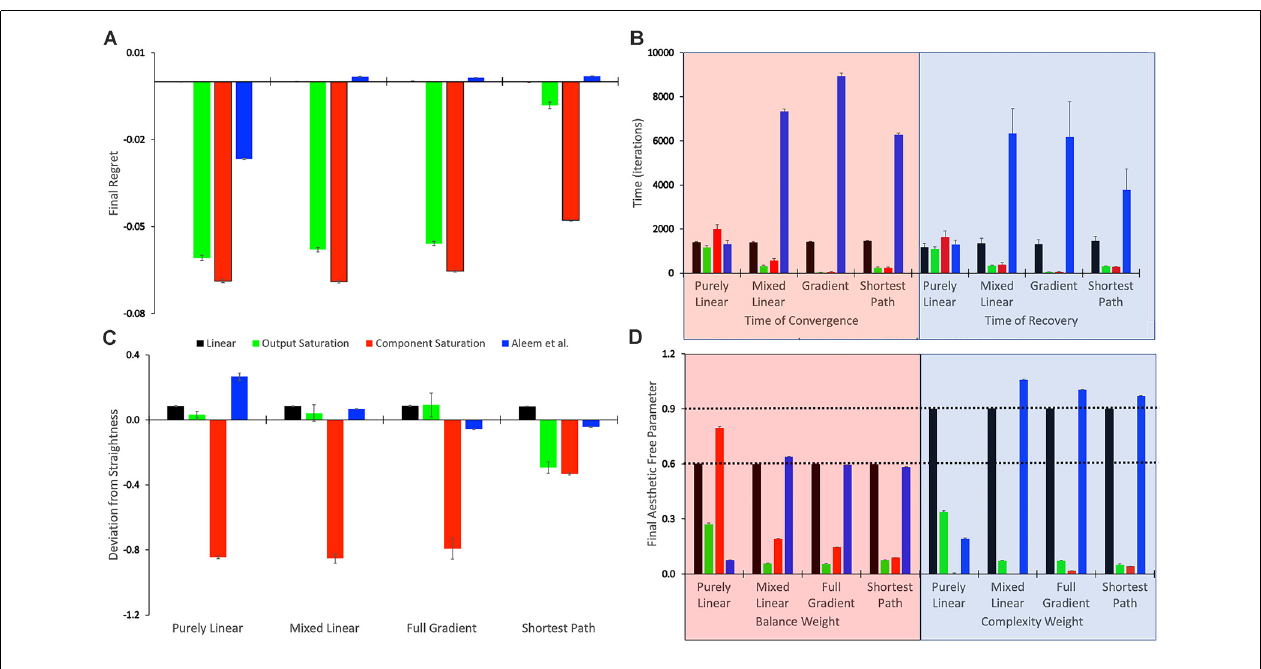
FIGURE 3 | Statistics of the tested conditions ( Table 1 ). (A) Final regret. (B) Times of convergence and of recovery from fluctuation errors. (C) Deviation from straightness. (D) Final free parameters of the value functions. each of these statistics was measured 10 times for each of the reward models, with the means and standard errors displayed. Color bins indicate the different reward models (colors matched to Figures 2E,F ). We group the 16 conditions in sets of four according to the experimental conditions ( Table 1 ). These sets were the purely linear, mixed linear, full gradient, and shortest path. The sets appear twice in Panel (B) , for time of convergence (transparent red) and time of recovery from fluctuation errors (transparent blue). Similarly, the sets appear twice in Panel (D) , for balance (transparent red) and complexity (transparent blue) free parameters. The dotted horizontal lines indicate the parameters of the linear reward